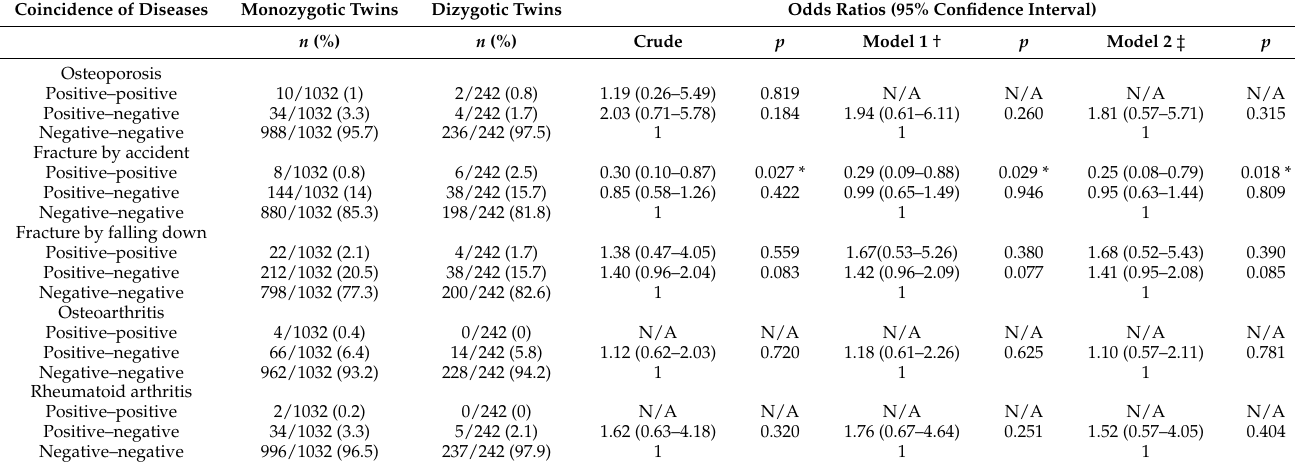
Table 3. Analysis of odds ratios with 95% confidence interval of occurrence of at least one bone disease in monozygotic twins compared to that in dizygotic twins (reference: negative/negative of diseases between twins).